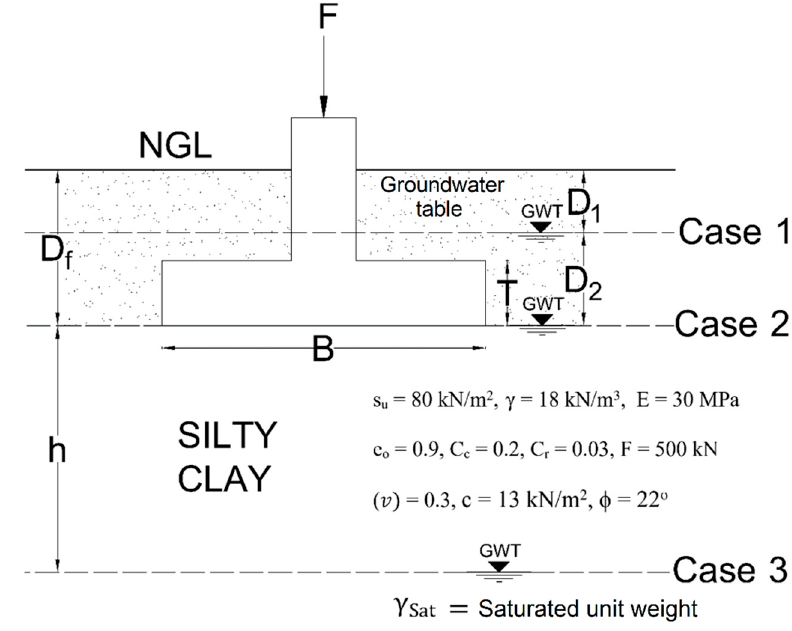
Figure 3. Isolated footing design example.